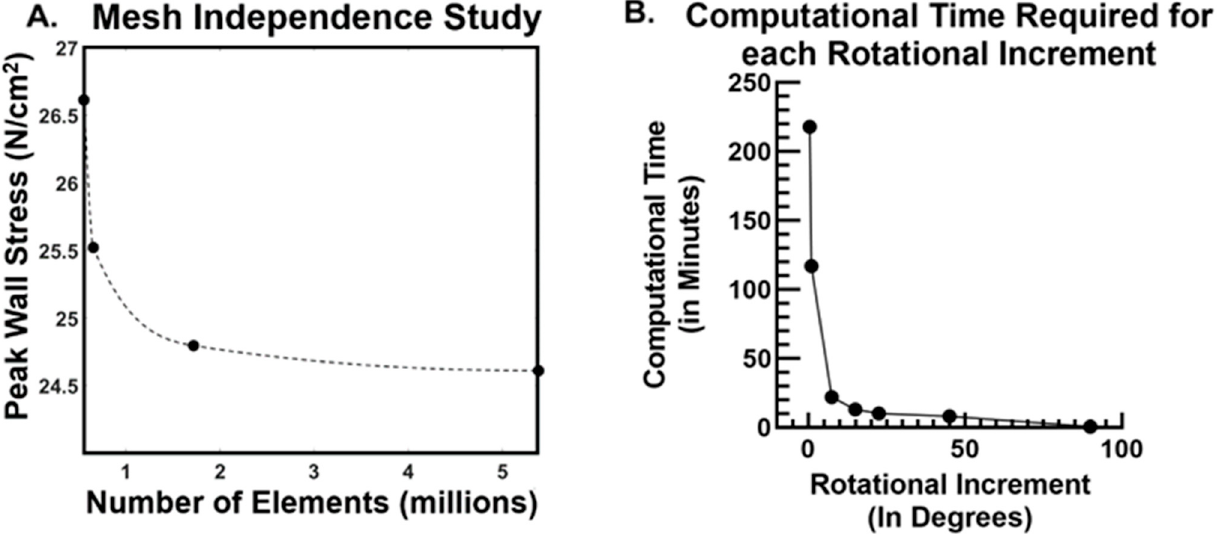
Figure 3. ( A ) Mesh independence study (data points were sampled) from ~600 k elements to 5.5 million elements. The points were spline fit to show a transition of a converging solution to report sac isolated peak wall stress values. ( B ) Total computational analysis time required to process all sac isolations ( n = 245) plotted against the rotational increment. The increments evaluated were 0.5°, 1°, 7.5°, 15°, 22.5°, 45°, and 90°.